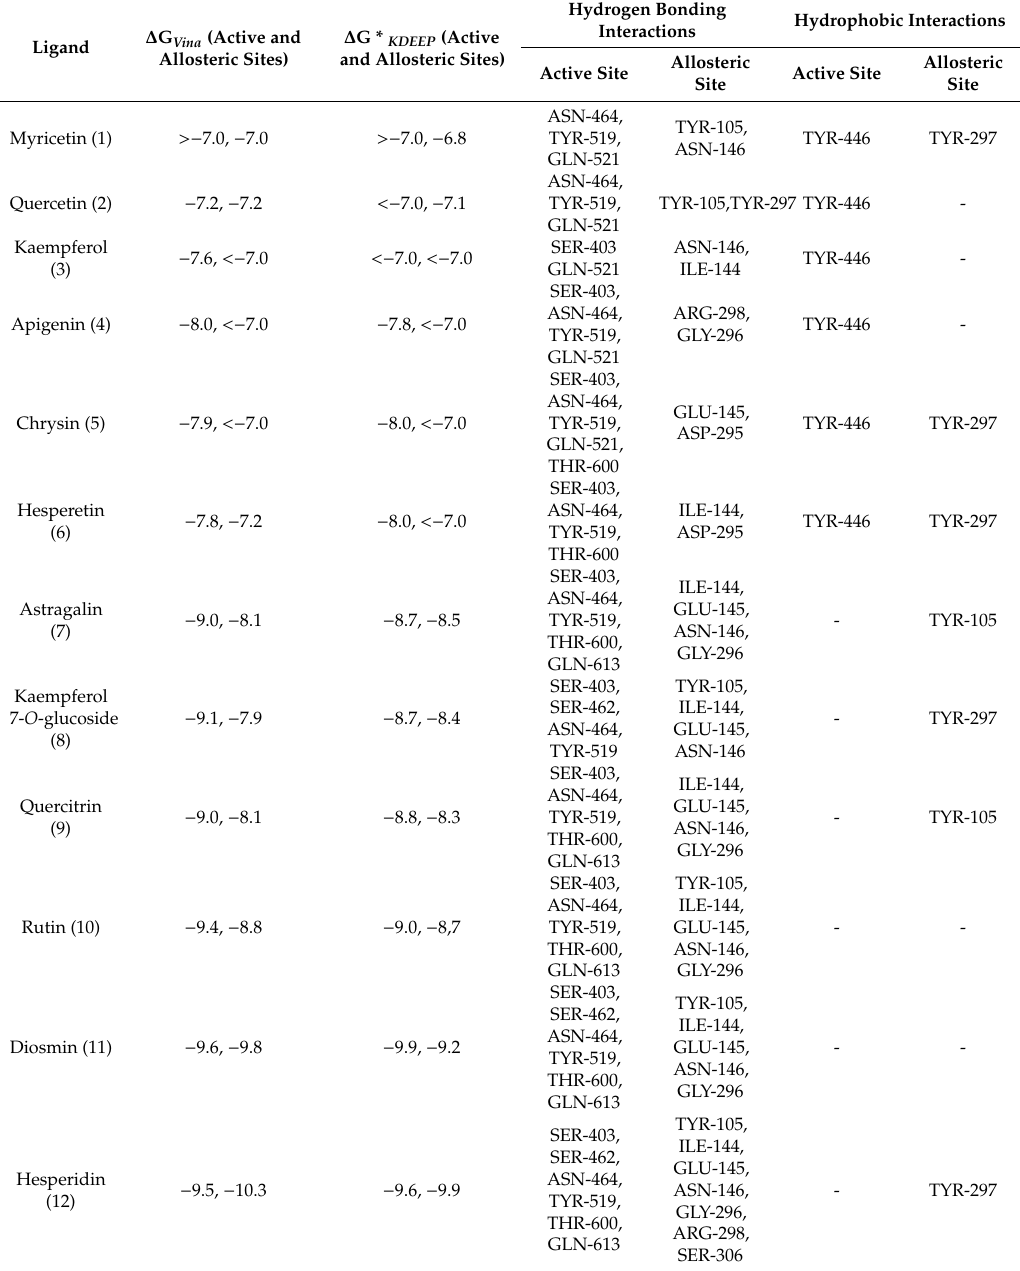
Table 1. Binding energies (in kcal / mol) of compounds 1–13 retrieved for both the active and allosteric sites together with their main molecular